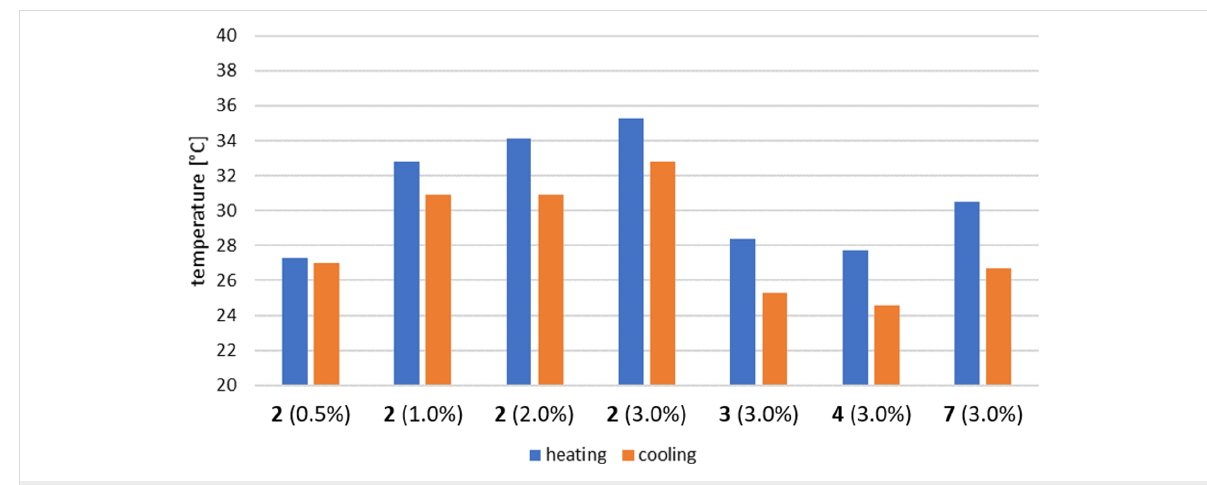
Figure 3: Phase transition temperature for the dirhamnolipid esters in toluene while heating ( T GS , blue) and cooling ( T SG , orange). The values were obtained from the phase angle ( δ = 45°).